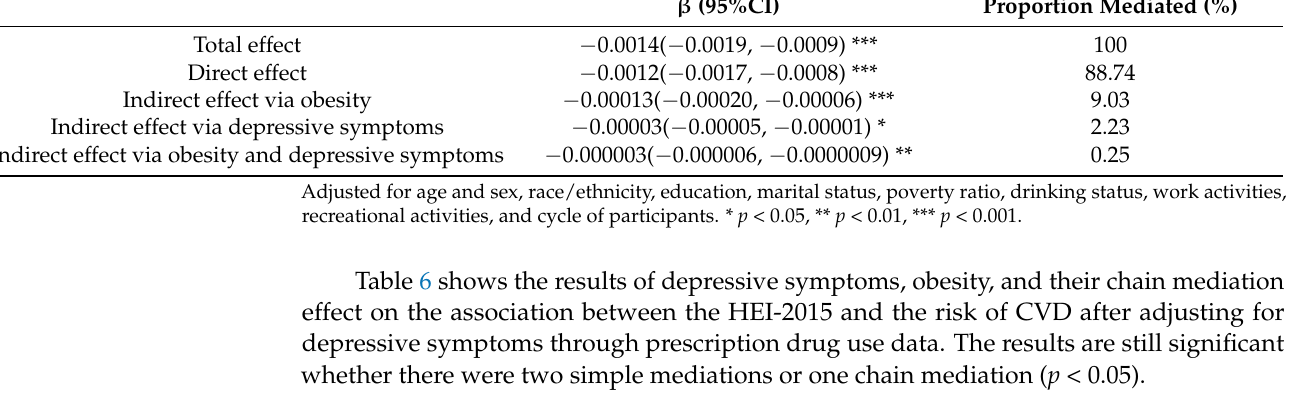
Table 6. After adjusting for depressive symptoms through prescription drug use data, the mediating proportion of obesity and depressive symptoms on the association between the HEI-2015 and the risk of cardiovascular